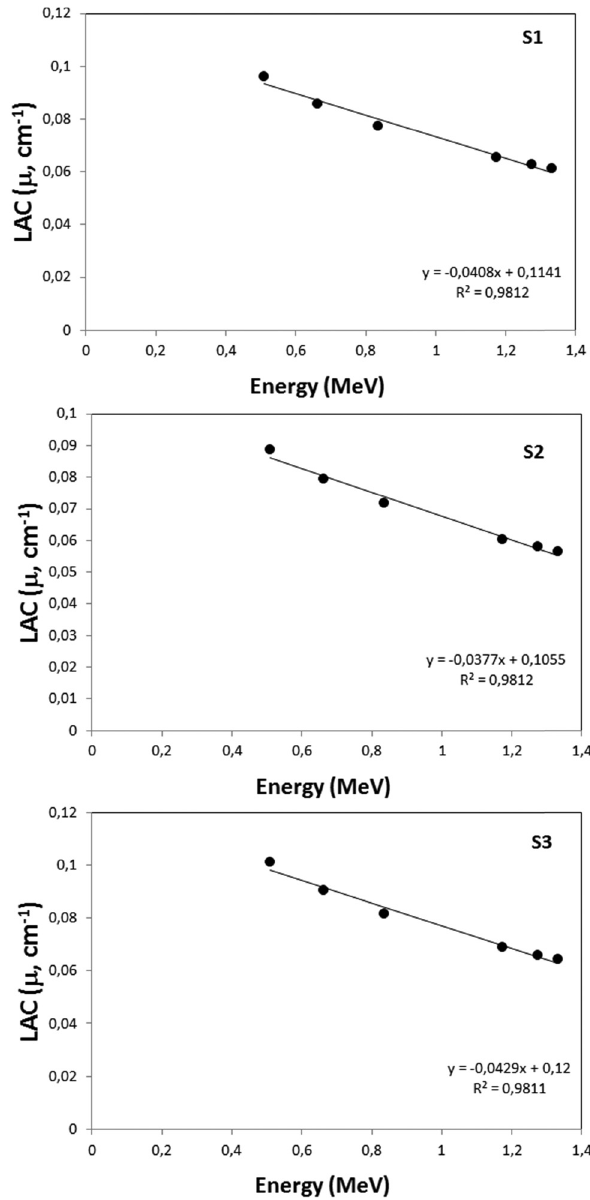
Figure 2: The LAC as a function of gamma - ray energies for four